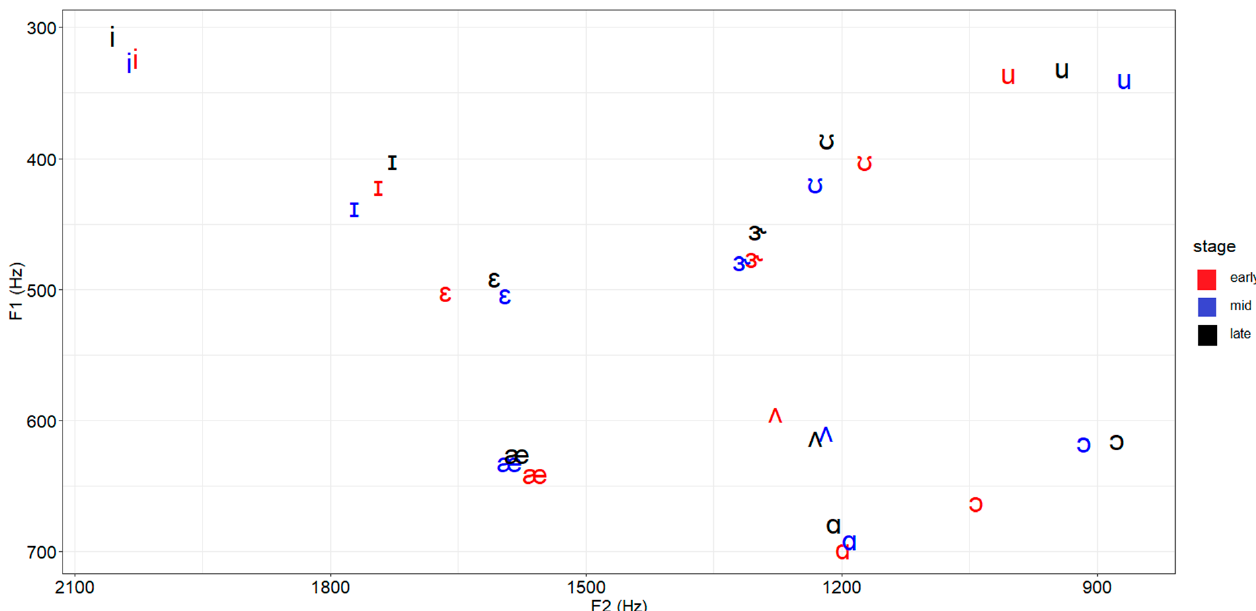
Figure 5. F1~F2 for AS’s English vowels.